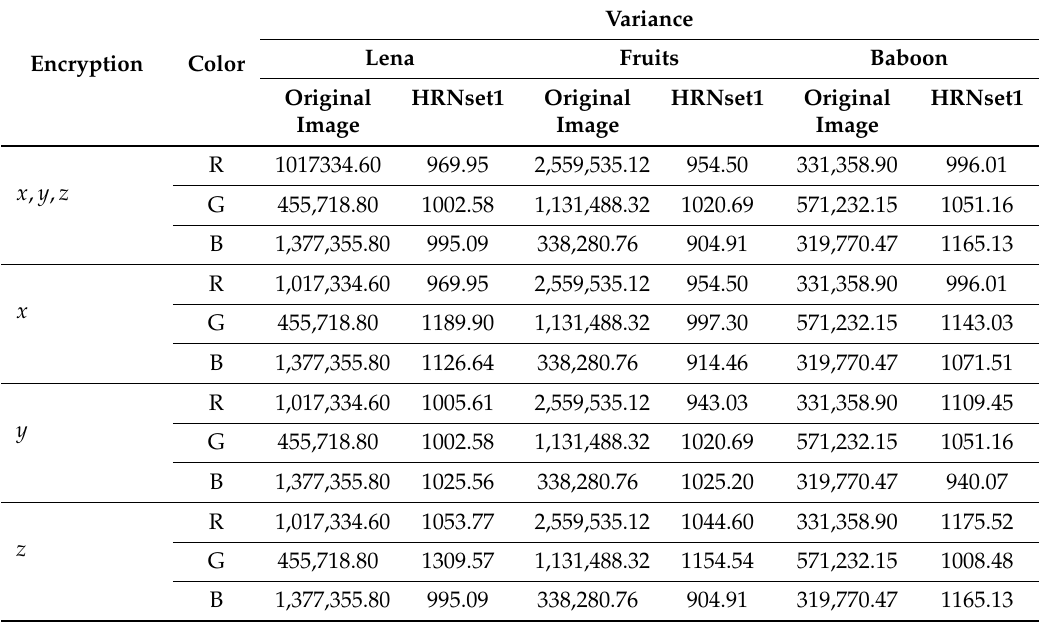
Table 14. Variance of the histograms for the Lena, Fruits and Baboon images using the sequences generated by